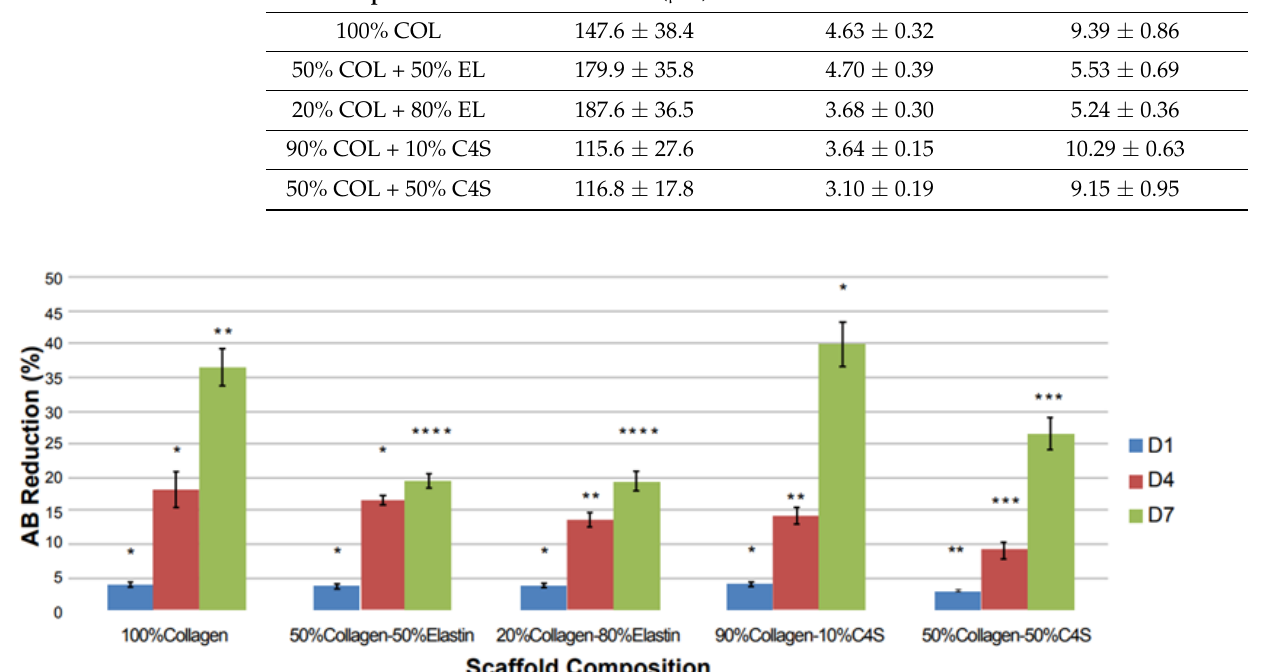
Figure 16. Proliferation of CDCs on scaffolds from day 1 to day 7 (*, **, *** and **** indicate statistically significant differences ( p < 0.05) between groups of different compositions). Reprinted with permission from ref. [230]. Copyright 2012, Hilaris.